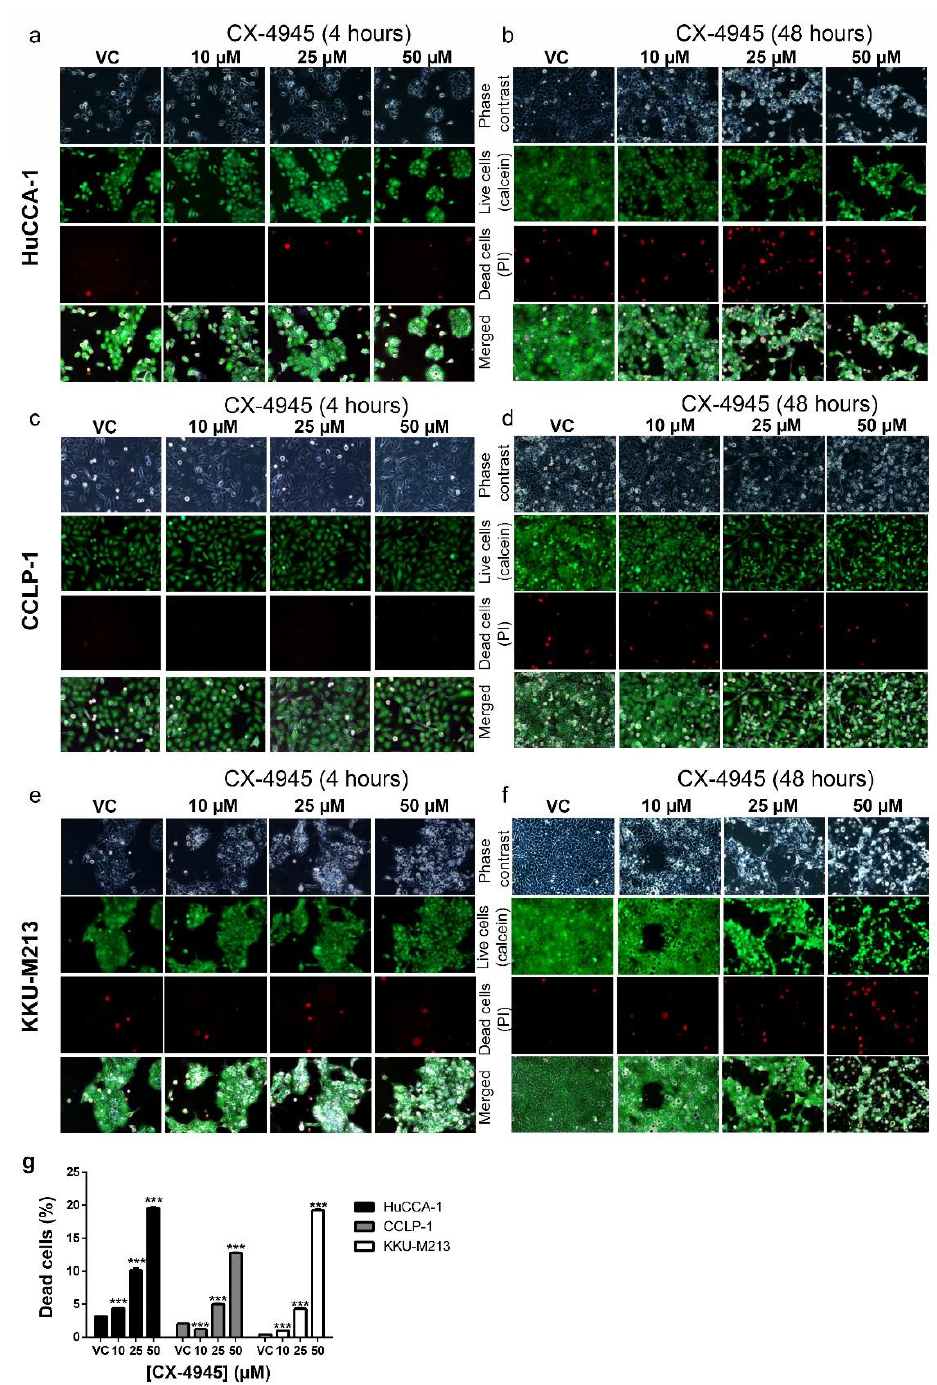
Figure 4. CX-4945 induced cell death. Propidium iodide staining showed that treatment with CX-4945 for 4 h did not induce cell death in ( a ) HuCCA-1, ( c ) CCLP-1, and ( e ) KKU-M213 cells. Extended CX-4945 treatment at 48 h, however, induced extensive cell death in ( b ) HuCCA-1 and ( f ) KKU-M213 cell lines. ( d ) Dead cell number was not increased in CCLP-1 treated with CX-4945 but live cell number clearly decreased in the 25 and 50 µM CX-4945 treated samples as well as in ( b ) HuCCA-1 and ( f ) KKU-M213 cell lines. ( g ) Percentage of dead cell increased in a dose-dependent manner in all three CCA cell lines. ***; p < 0.001, Pictures are representative of the results from three independent experiments.